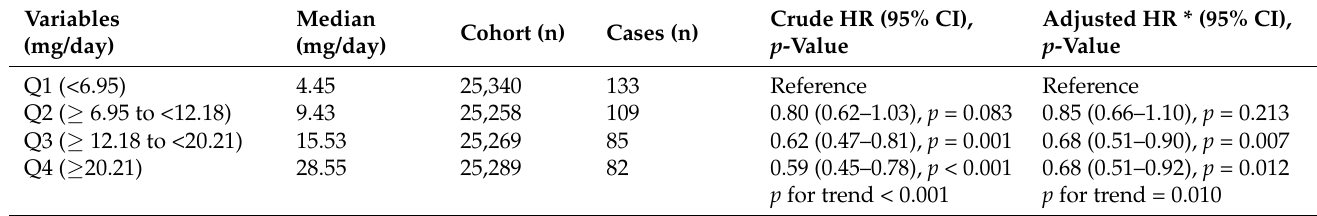
Table 2. Association between dietary anthocyanidin intakes and renal cancer